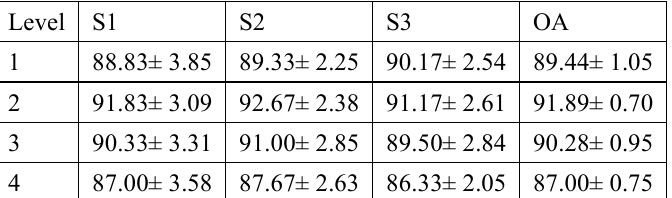
Table 7. Results of different decomposition